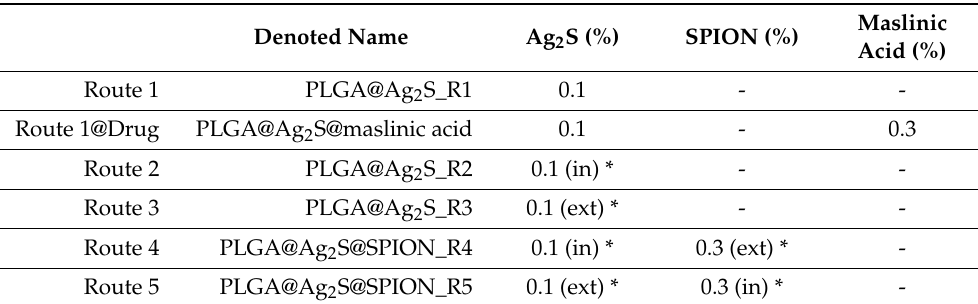
Table 1. Composition in percentage and place of injection of the different routes.